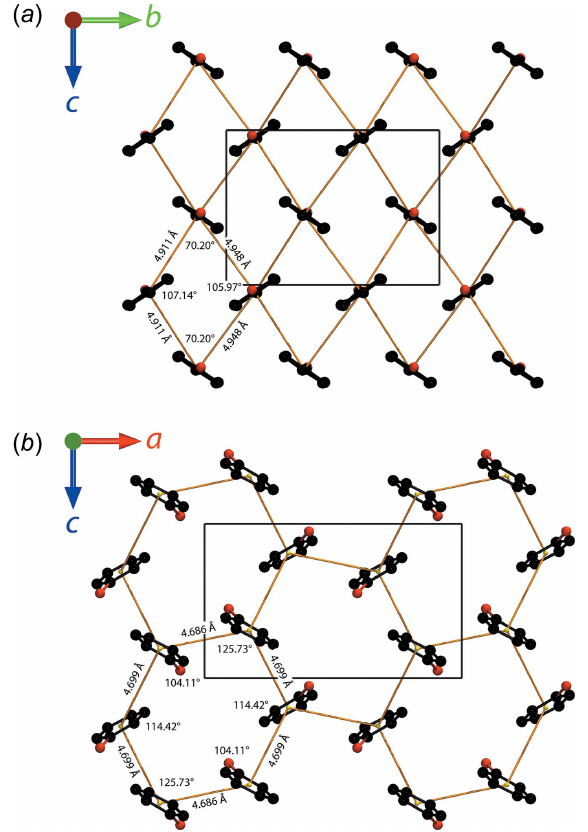
Figure 4 Molecular packing in phenol hemihydrate ( a ) from this work and ( b ) from Meuthen & von Stackelberg (1960). Hydrogen atoms are omitted for clarity. Shaded rectangles indicate sections through slabs of closest- packed phenol molecules, which are drawn explicitly in Fig. 5.